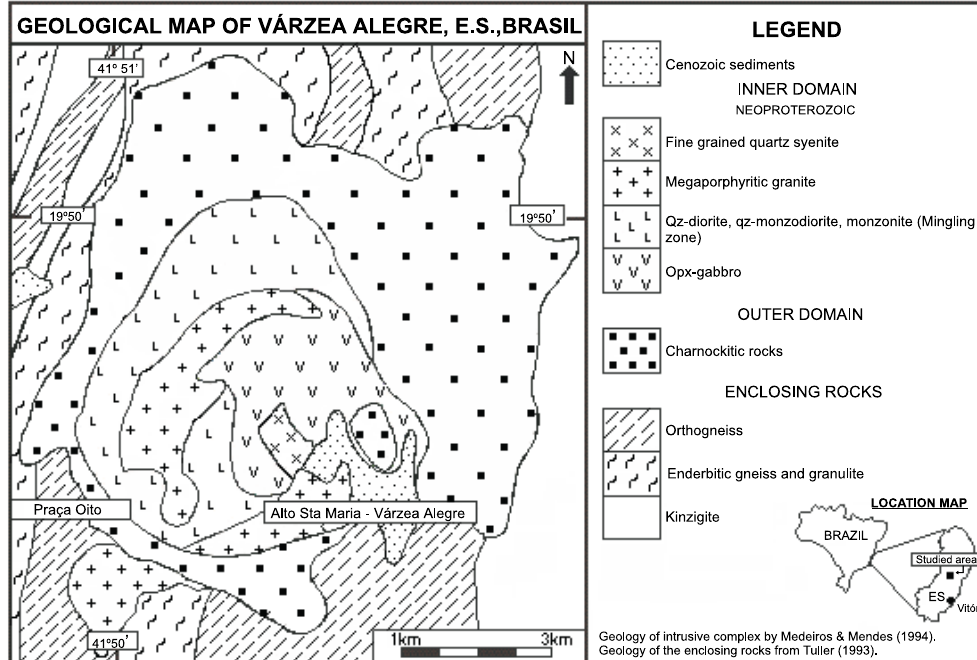
Fig. 1 – Geological map of the Varzea Alegre Intrusive